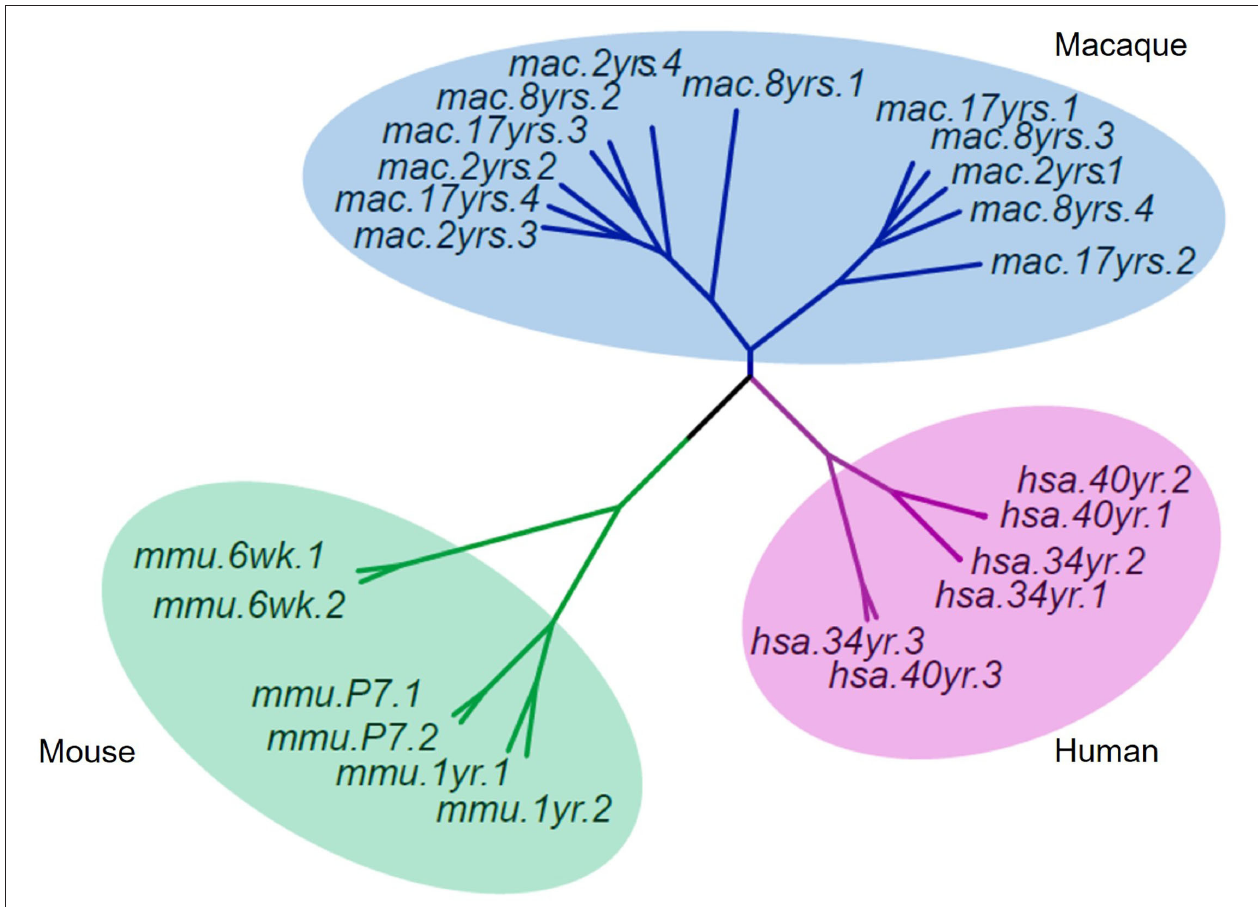
FIGURE 7 | Cluster dendrograms of 5hmC among rhesus, human, and mouse. The 5hmC pattern of the rhesus monkey was closer to that of humans than